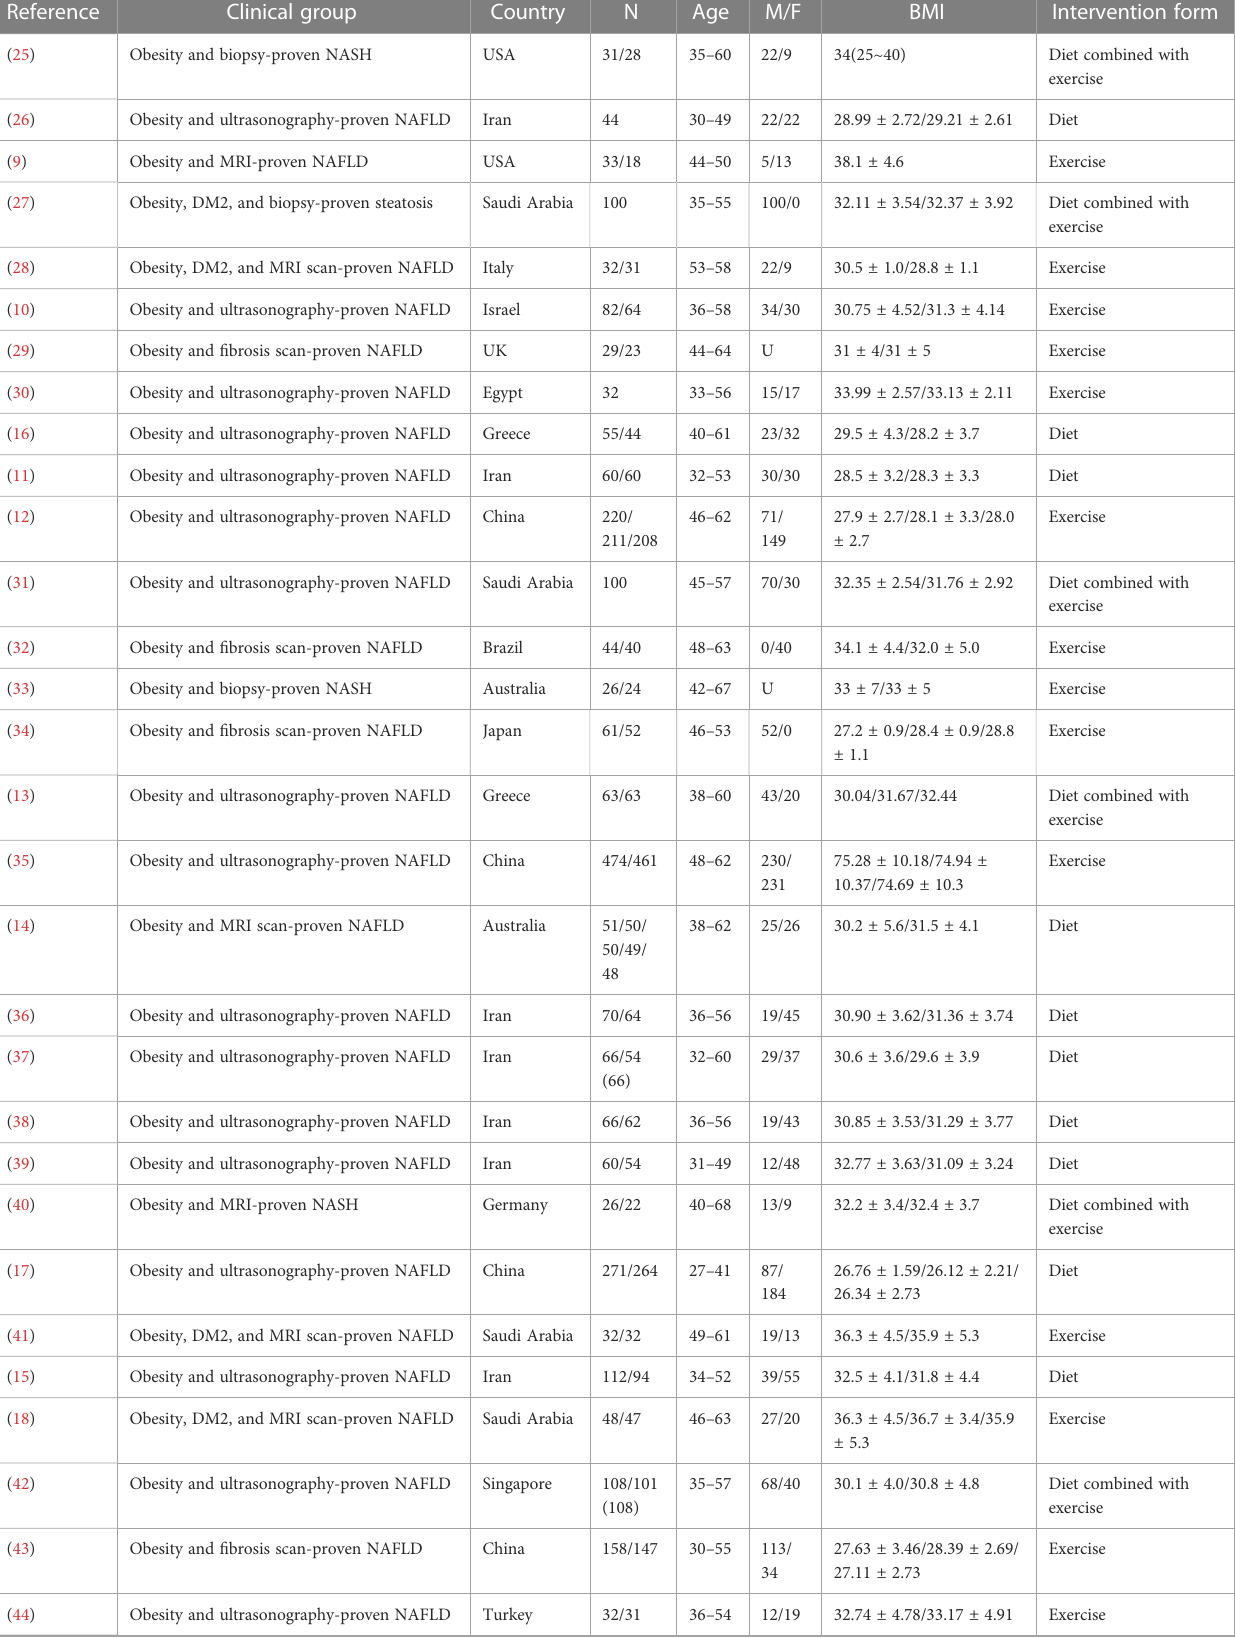
TABLE 2 Characteristics of the included